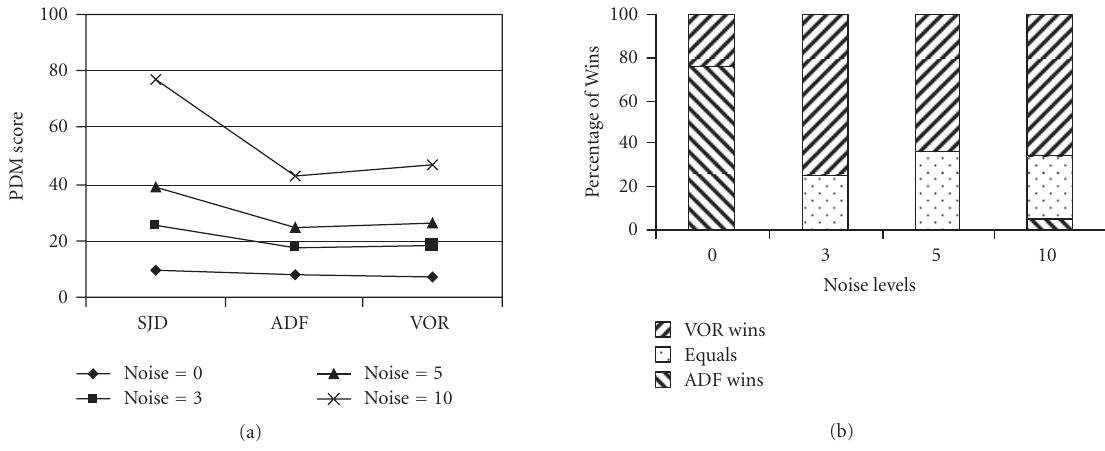
Figure 7: The comparison of density compensation functions. The average performance of three density compensation functions under di ff erent noise conditions is shown in the logarithm chart in (a). ADF and VOR show obvious advantages over SJD. ADF and VOR are compared case by case in same conditions, and the statistical results are shown in (b). For noise conditions, we have tested 100 realizations for each image, and the PDM scores are statistically analyzed. In (b), the “equals” are observed when a t test shows no significant di ff erence ( p > 0 . 05). This does not apply to the noise-free